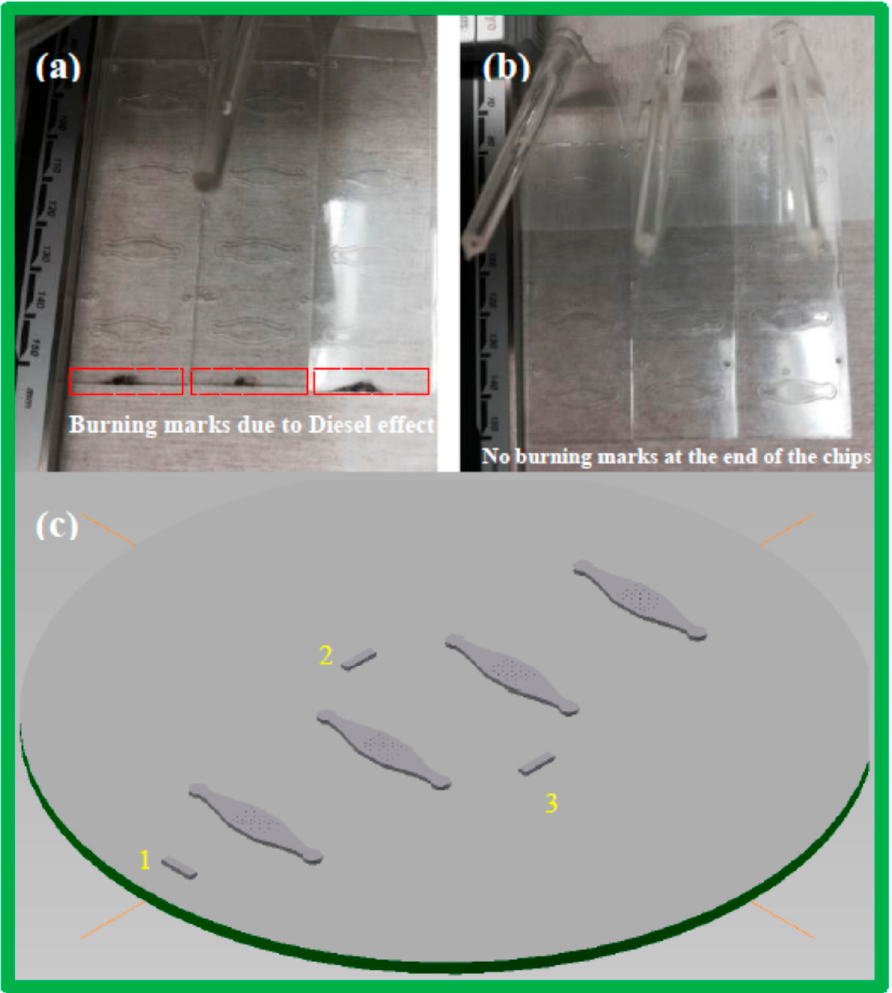
Figure 8. ( a ) Burn marks at the end of the chips due to the diesel e ff ect. ( b ) Polymer chips without the diesel e ff ect, as the shim used had only three alignment marks. ( c ) Shim with 3 alignment marks instead of 4 (as shown in Figure 7). The injection point is approximately at position 1 in the injection moulding machine.